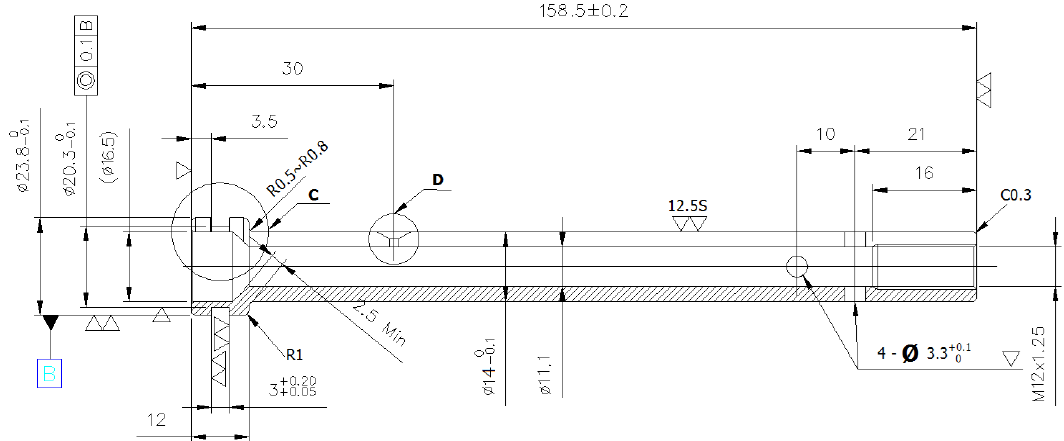
Figure 1. Technical drawing of a motorbike shock absorber.